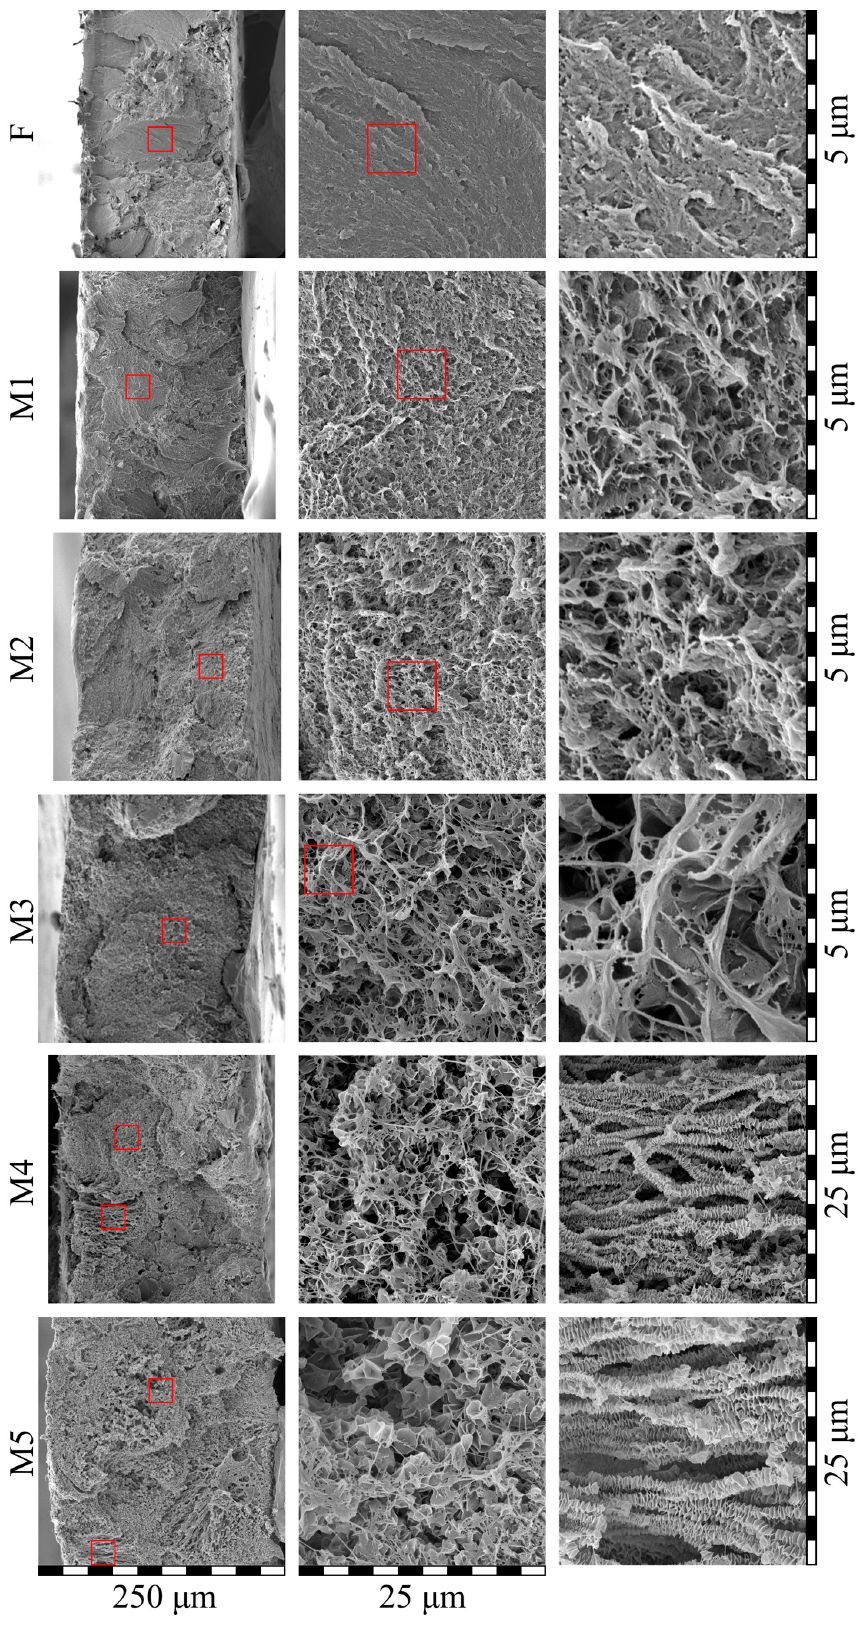
Figure 8. SEM images of the cross-section of the initial film (F) and membrane samples (M1–M5). Red squares highlight the regions where higher magnification images (shown to the left) were taken.